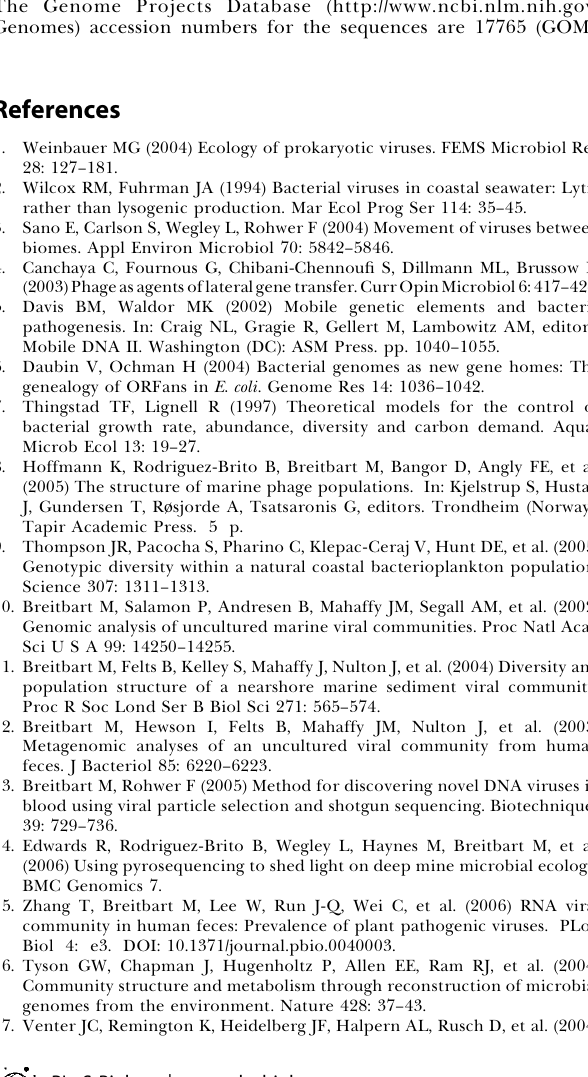
Figure S2. Relative Abundance of Phages in the Four Metagenomes Because of way the samples were stored and the long storage time, the distribution shown may not accurately reflect the reality. Found at DOI: 10.1371/journal.pbio.0040368.sg002 (104 KB TIF) Figure S3. Determining a Normal Contig Spectrum Found at DOI: 10.1371/journal.pbio.0040368.sg003 (135 KB TIF) Figure S4. Getting a Cross-Contig Spectrum. Found at DOI: 10.1371/journal.pbio.0040368.sg004 (3.1 MB TIF) Figure S5. The Possible Scenarios Considered in the Monte Carlo Simulation to Explain the Observed Cross-Contigs Found at DOI: 10.1371/journal.pbio.0040368.sg005 (143 KB TIF) Figure S6. Analyzing a Cross-Contig Spectrum Found at DOI: 10.1371/journal.pbio.0040368.sg006 (589 KB TIF) Protocol S1. Details on Materials and